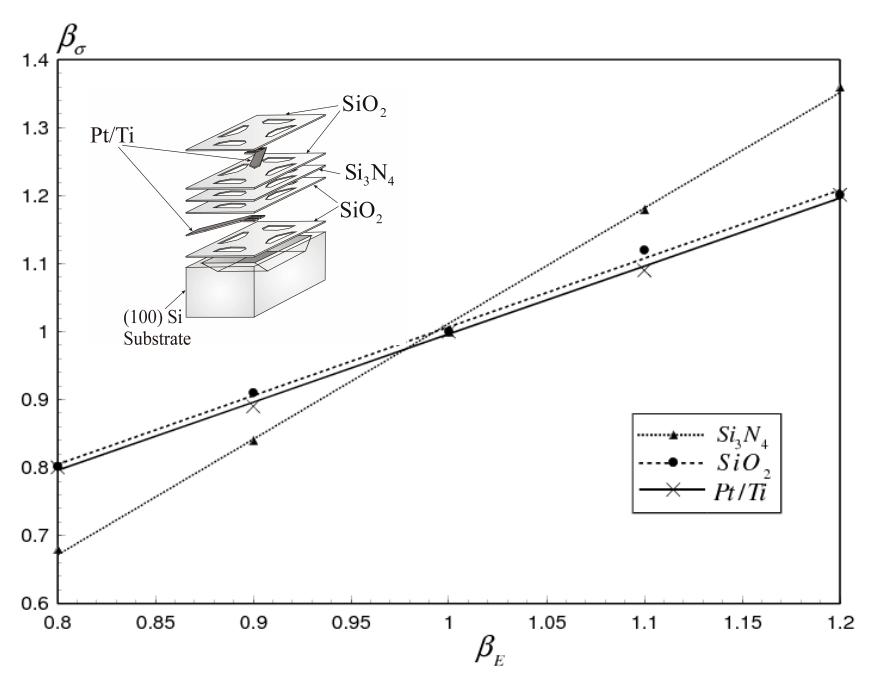
Figure 12. Effect of the variation of Young’s modulus on the maximum thermal stress of different gas sensor materials